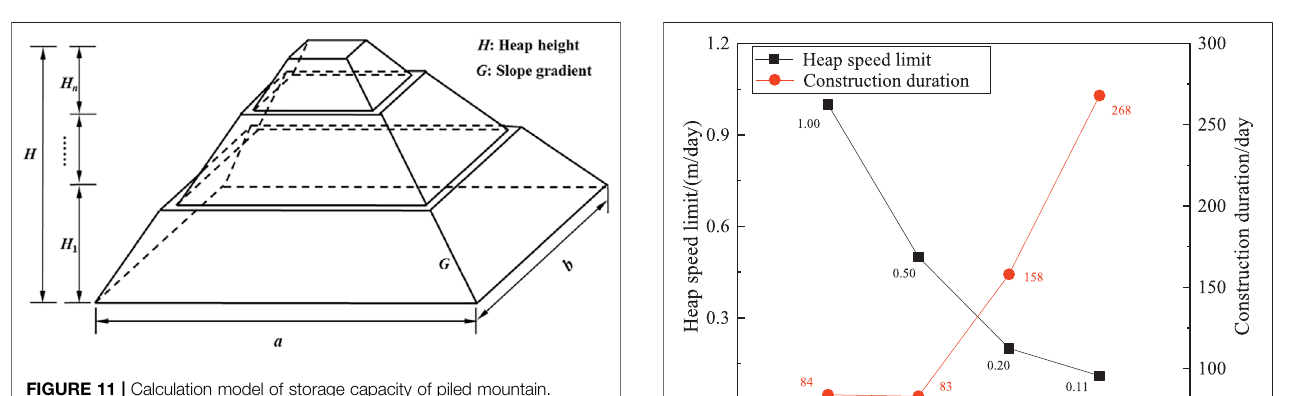
FIGURE 11 | Calculation model of storage capacity of piled mountain.